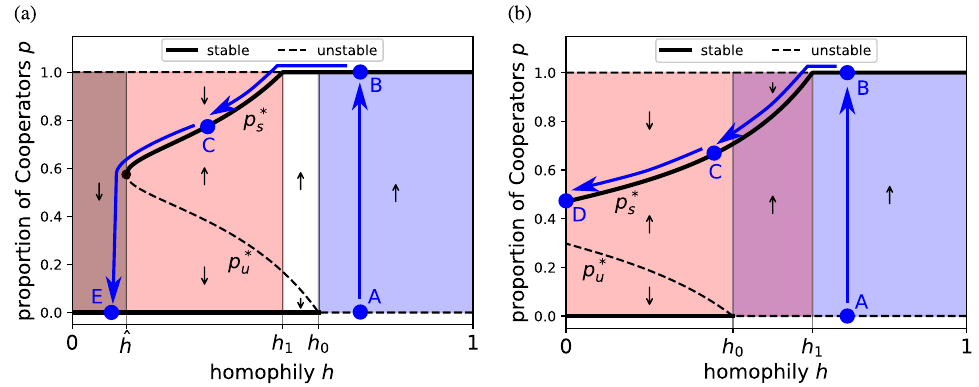
Figure 3. Two examples of how genetic homophily affects the evolutionary dynamics in our model, showing possible trajectories of cooperation as human homophily (tendency to interact with genetically related others) decreased over time due to changing social environments (blue lines). The evolutionary dynamics separates ˆ h , Cooperators cannot persist into qualitatively different regimes depending on the homophily level: h < (dark shading); h < h 1 , Defectors can both invade and persist (red shading); h > h 0 , Cooperators can invade (blue shading). In the human ancestral past (e.g., > 1.6 Ma 33 ), homophily was high (point A), which under the model would have allowed cooperation to invade (B). As interactions with nonkin increased ( h decreased), Cooperation persisted even into the region where it could not invade (C). Depending on the parameter values, Cooperation can either persist even if homophily disappears entirely (i.e., all interactions become nonkin; D) or be lost below a certain level of homophily (E). The example illustrated uses the members-recruit group- formation model ( h ≡ 1 − q ) with parameter values n = 8 , W = 2 , Y = 3 , Z = 0 ; ( a ) τ = 5 , X = − 1 ; ( b ) τ = 4 , sigmoid